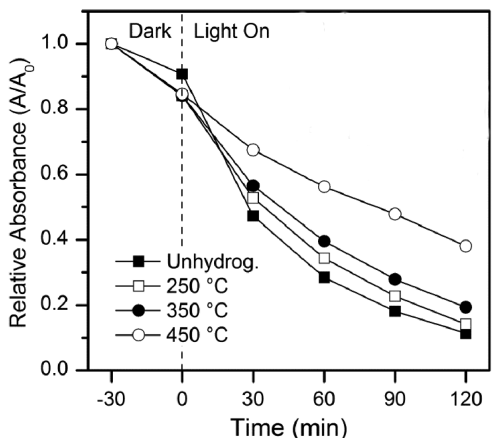
Figure 9. Photocatalytic oxidation of methylene blue under simulated solar light for nonhydro- genated (“Unhydrog.”) and hydrogenated titania samples at different temperatures. Reprinted with permission from [101]. Copyright 2013, American Chemical Society.